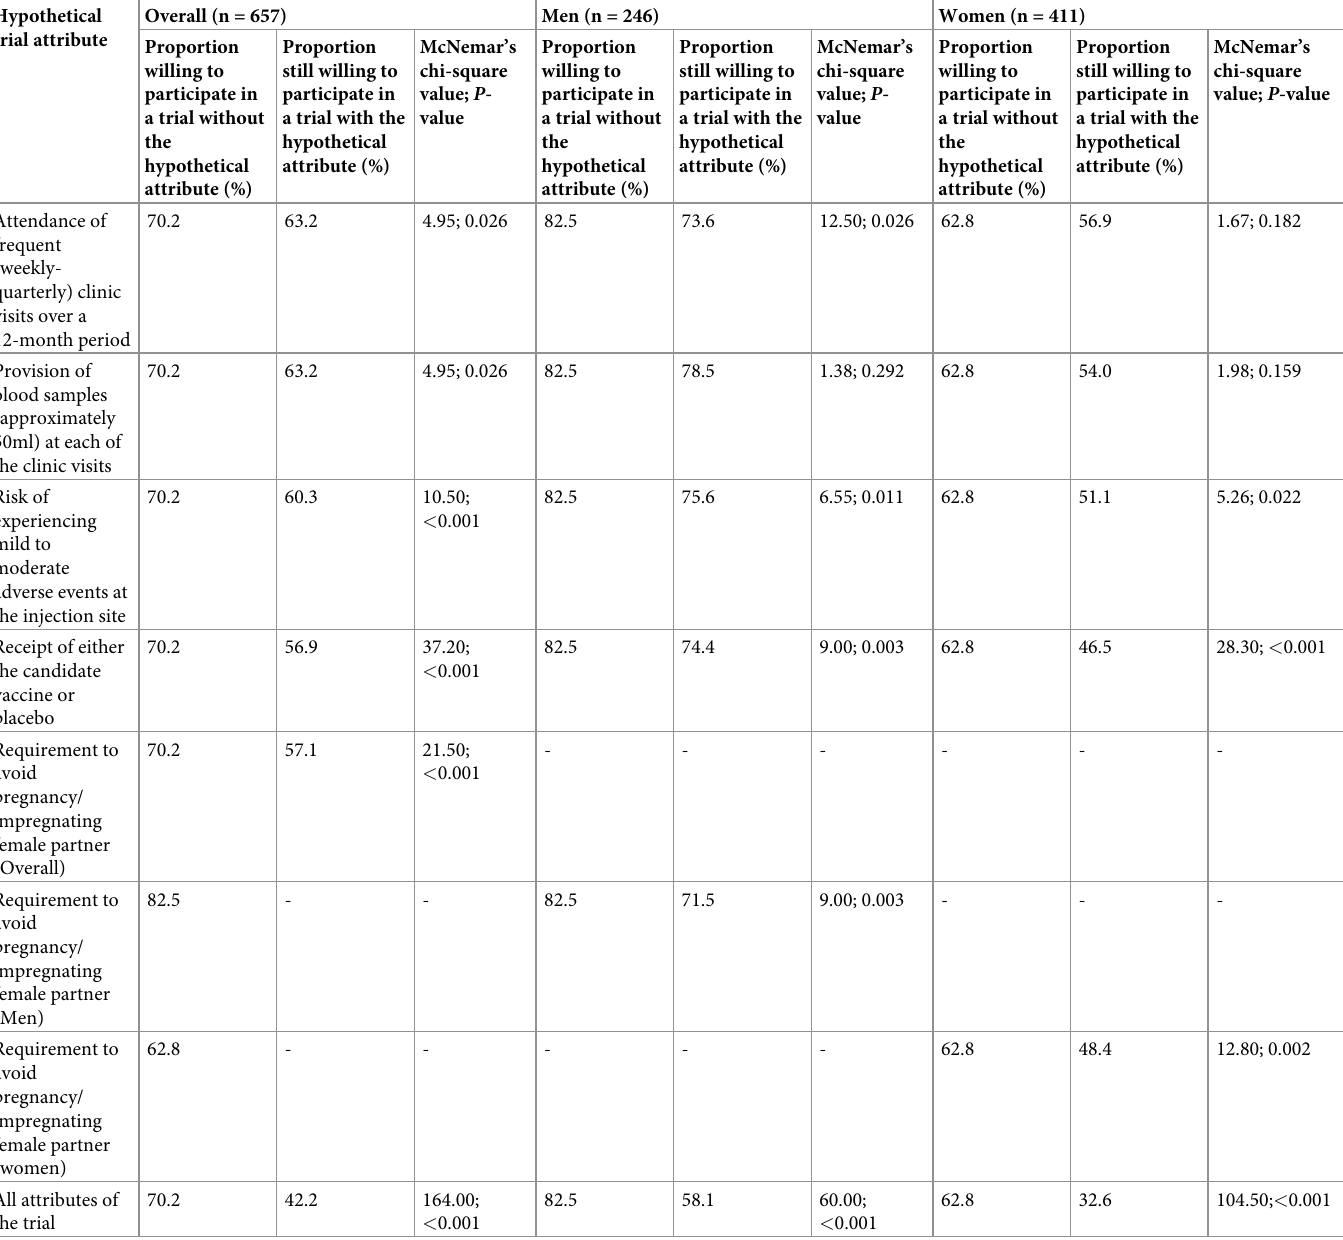
Table 1. Impact of trial attributes on willingness-to-participate in COVID-19 vaccine trials (overall and by